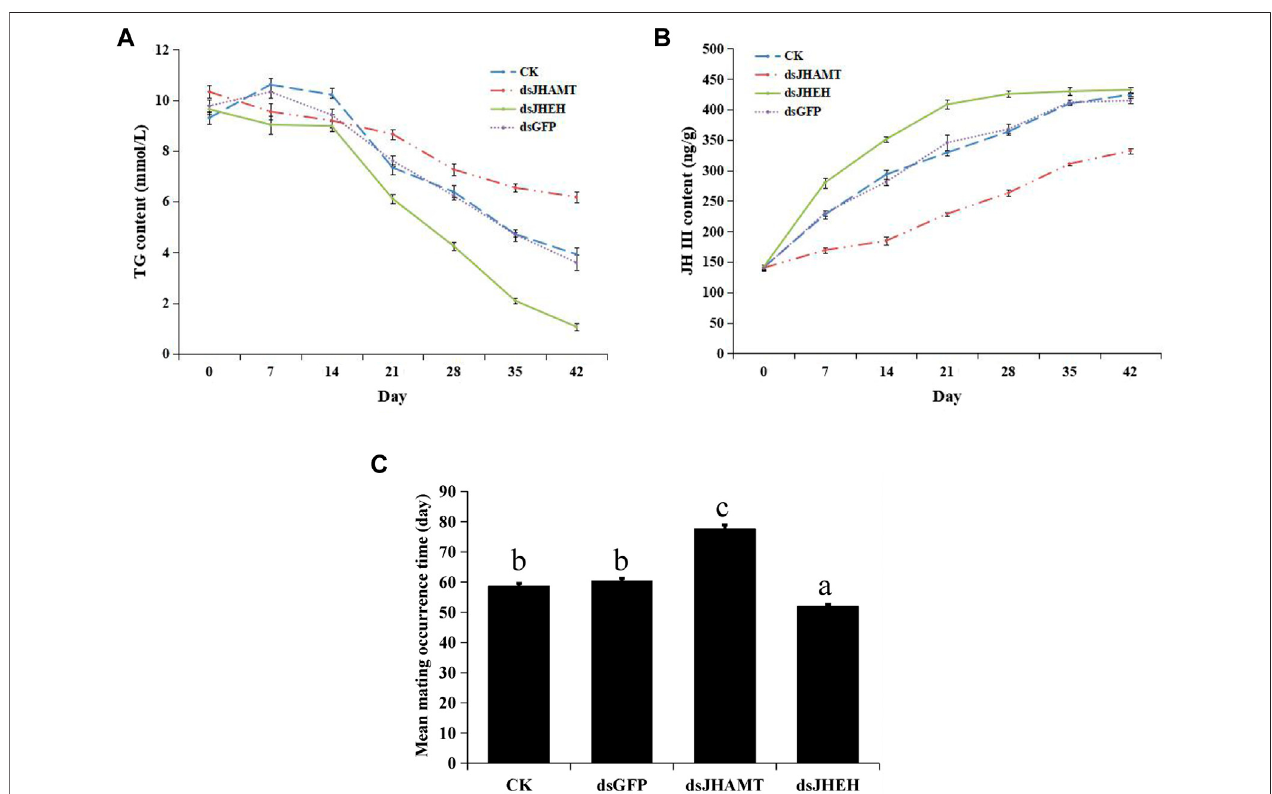
FIGURE 9 | Triglyceride content (A) , juvenile hormone concentration (B) and mean mating occurrence time (C) after dsRNA injection. The different lowercase letters above bar are signi fi cant difference at p < 0.05 (one-way ANOVA followed by Duncan ’ s multiple comparison).